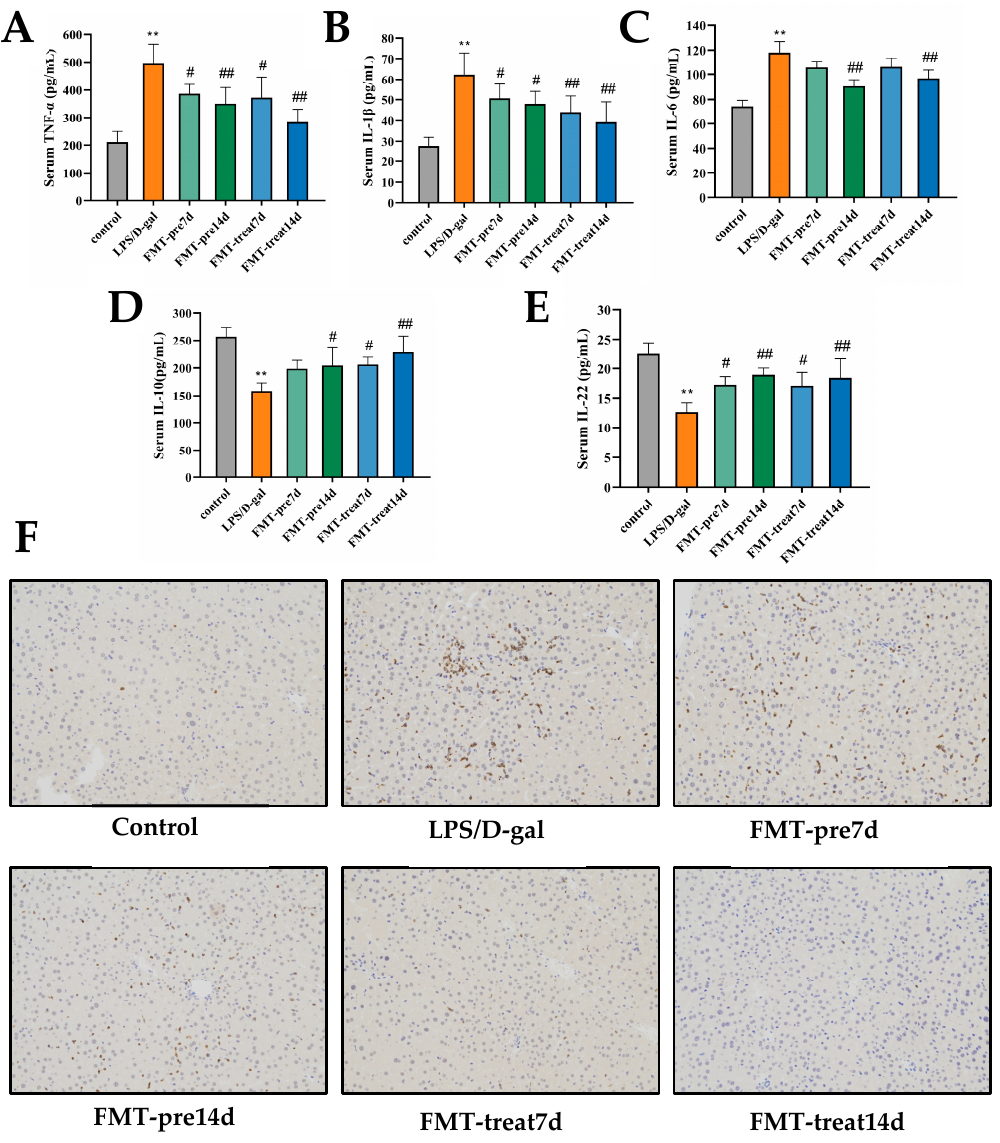
Figure 2. FMT ameliorated inflammatory response in LPS/D-gal-induced mice. ( A – E ) Serum TNF α , IL-1 β , IL-6, IL-10, and IL-22 levels ( n = 6). ( F ) Micrographs of liver sections stained with MPO antibody (magnification × 200). ** p < 0.01 vs. control group, # p < 0.05, ## p < 0.01 vs. LPS/D-gal group. Dates were expressed as means ±SEM.